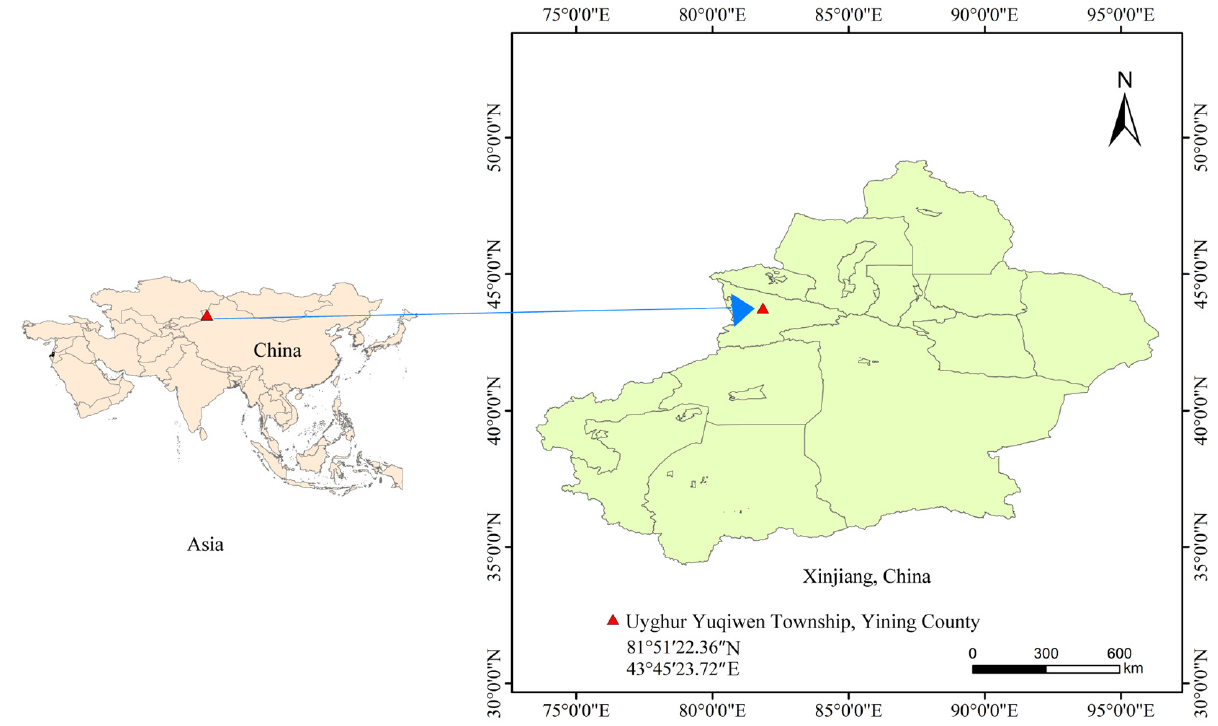
Figure 1. The location of the study site.